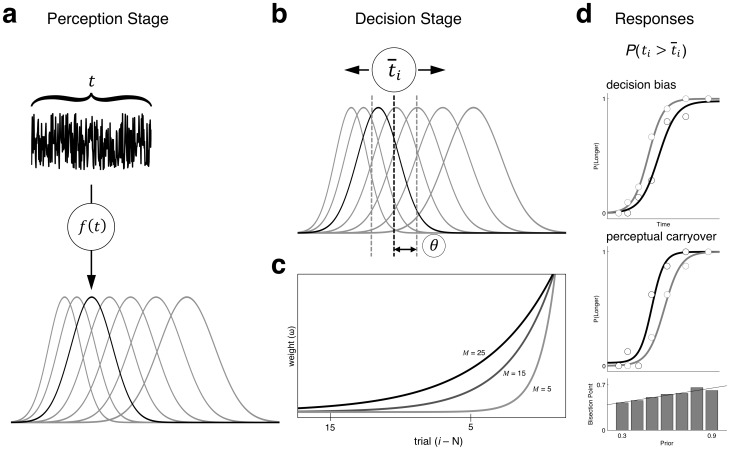
Implicit memory model schematic.(a) On a given trial, a temporal interval t (here, auditory) is perceived as a draw from a Gaussian noise distribution f(t) that varies between trials and scales with longer durations (normalized here for presentation). (b) Once the length of the interval is perceived, the estimate is compared to the present criterion, (black dashed line), which changes from trial to trial depending on the prior distribution of trials. An uncertainty threshold, θ (gray dashed lines) indicates the distance surrounding the criterion beyond which an interval can be accurately discriminated, and is also drawn from a Gaussian distribution. (c) The memory criterion was formed by adaptively weighting a limited number of intervals in the immediate stimulus history, limited by a given memory window size (M). The weighting function of preceding intervals (ω) exponentially decayed in time and was proportional to M, such that larger window sizes led to a longer decay function and a greater influence of intervals further back in the stimulus history; curves represent the decay function for different values of M. (d) The decision stage on each trial ideally categorized perceived stimuli as longer or shorter than the criterion if they exceeded uncertainty. The model reproduced patterns of decision bias (top graph: gray line  =  prior resp(shorter); black line  =  prior resp(longer)) by selecting the prior response when uncertainty could not be overcome, and exhibited perceptual carryover (middle graph: gray line  =  prior dur(900 ms); black line  =  prior dur(300 ms)) by judging each stimulus relative to the adaptive prior. Bottom graph displays model data bisection points displaying a linear (contrastive) effect of prior interval.